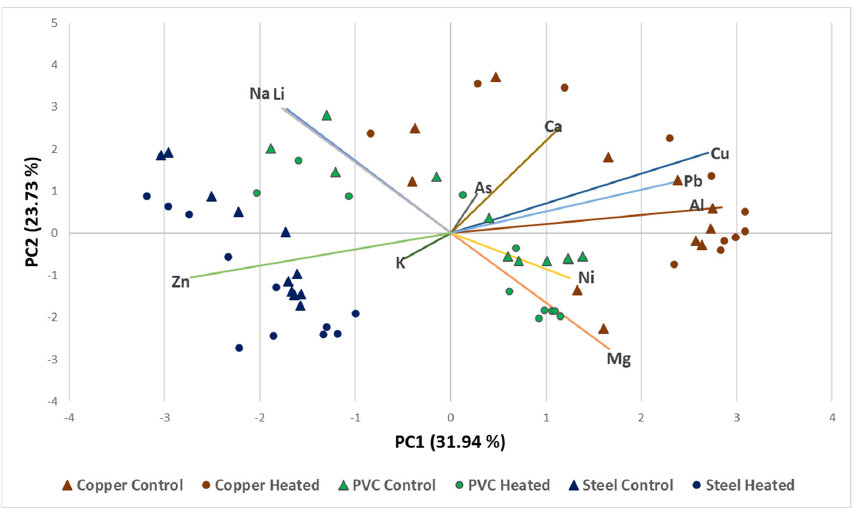
Figure 2. Divergence among DWDSs based on the PCA ordination biplot of chemical analysis.